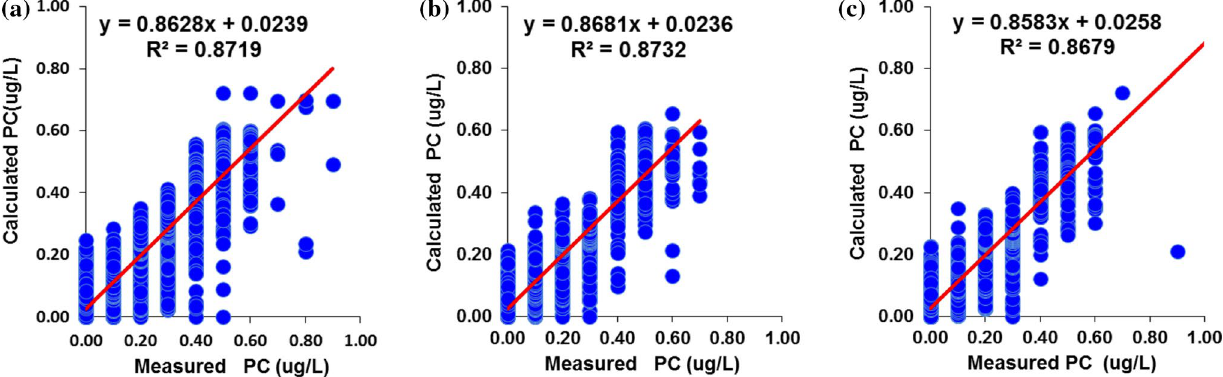
Fig. 10 Scatterplots of estimated versus measured values of PC for GEP (M1) model: a training, b validation and c test data—station